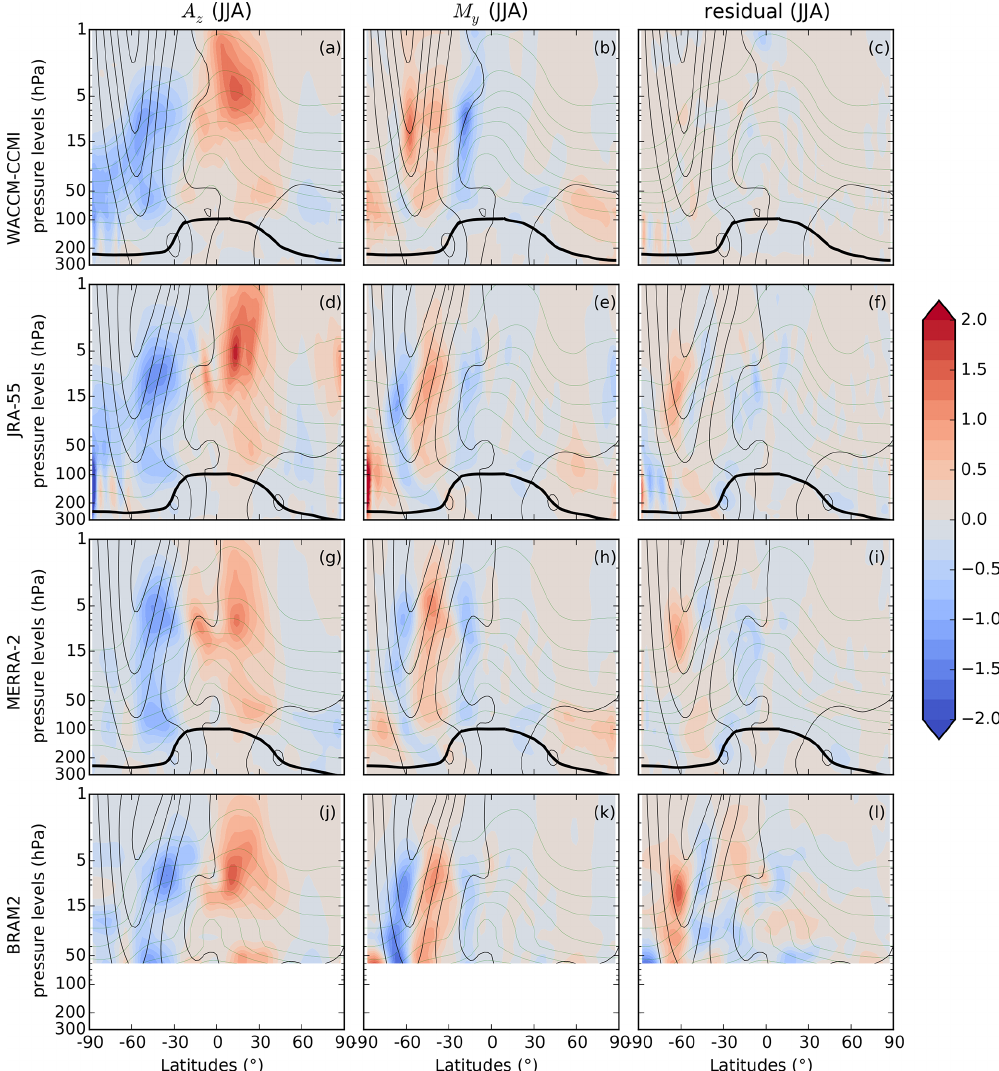
Figure 4. Same as Fig. 3 but for JJA and with a different color scale. The thin black contours show the zonal-mean zonal wind (from 0 to 100ms − 1 every 20ms − 1